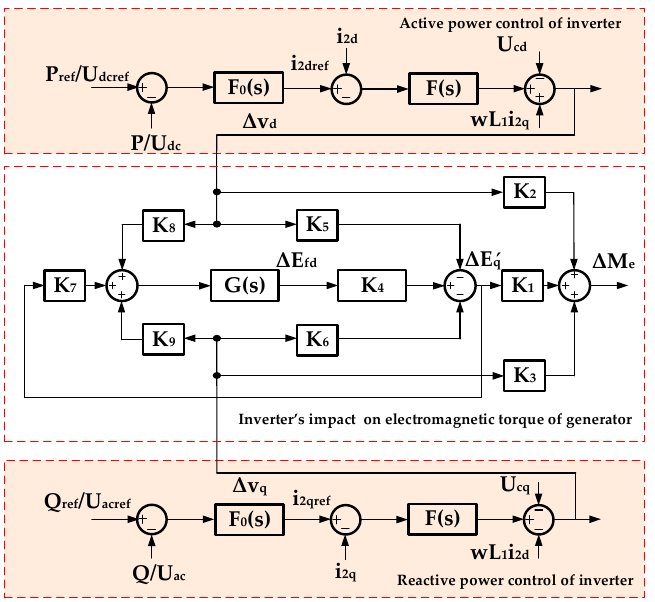
Figure 5. The small-signal model of the inverter output and the generator electromagnetic torque. According to the control block diagram and the superposition principle, the transfer functions of Δ M e / Δ V d and Δ M e / Δ V q are obtained, respectively: